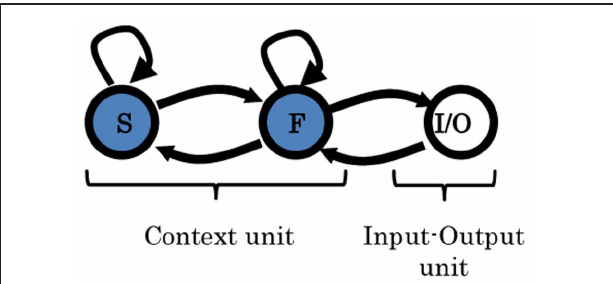
FIGURE 4 | Two-level MTRNN model. Arrows indicate the direction of the synaptic connections between the units. The input/output unit (I/O) is fully connected to itself, as well as to the fast context unit (F). F-unit is connected to itself, as well as, to I/O and to the slow context unit (S). S-unit is connected to itself and to the F-unit as well. More details are given in Table 1